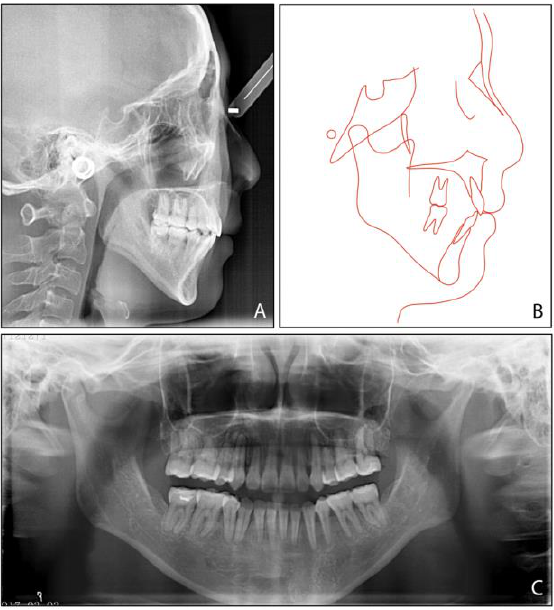
Figure 9. Post-treatment radiographs and tracing: ( A ) cephalometric radiograph; ( B ) cephalometric tracing; ( C ) panoramic radiograph.